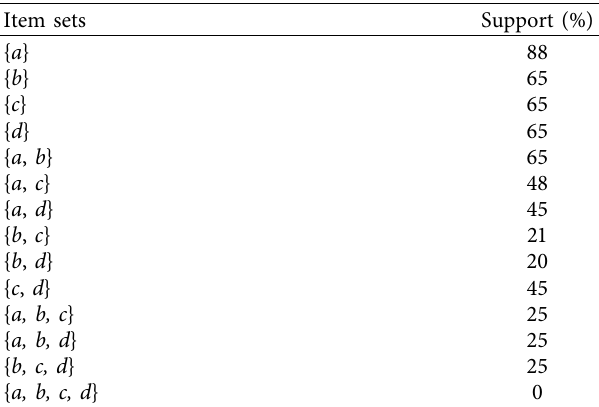
Table 2: All item sets and support.